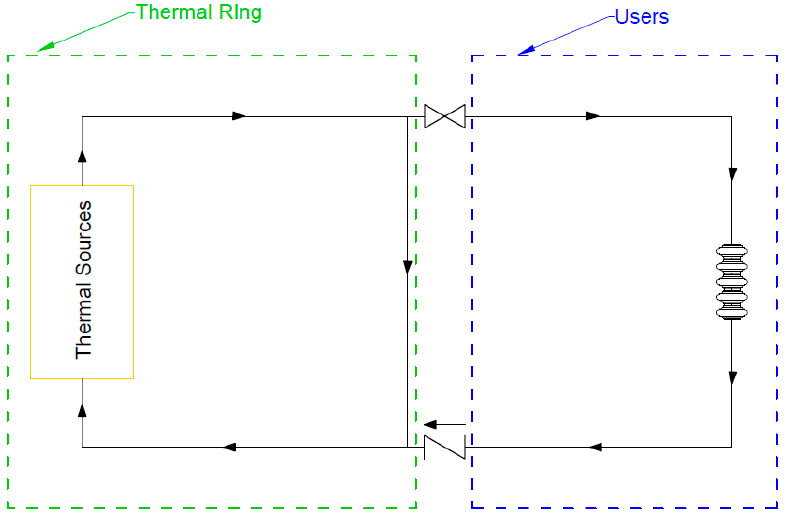
Figure 1. Schematic representation of the thermal circuit considered for the proposed methodology: the “thermal ring” (TR) involves the thermal sources and the thermal network while the “user” (U) represents the thermal loads fed by the network.